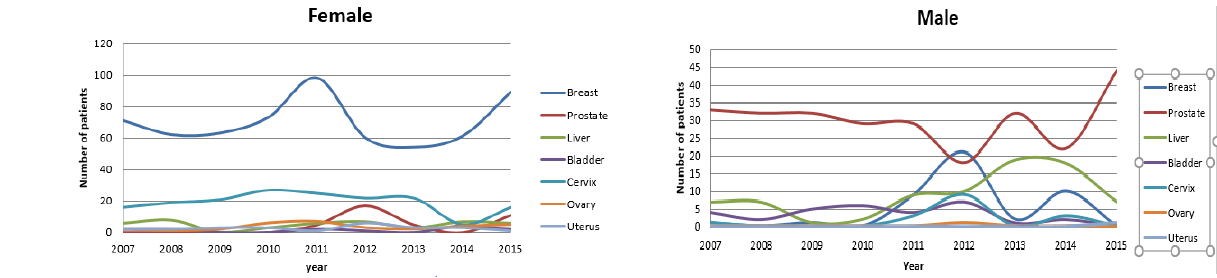
Fig. 3. Trends of common cancers in females (2007-2015) Fig. 4. Trends of common cancers in males (2007-2015)